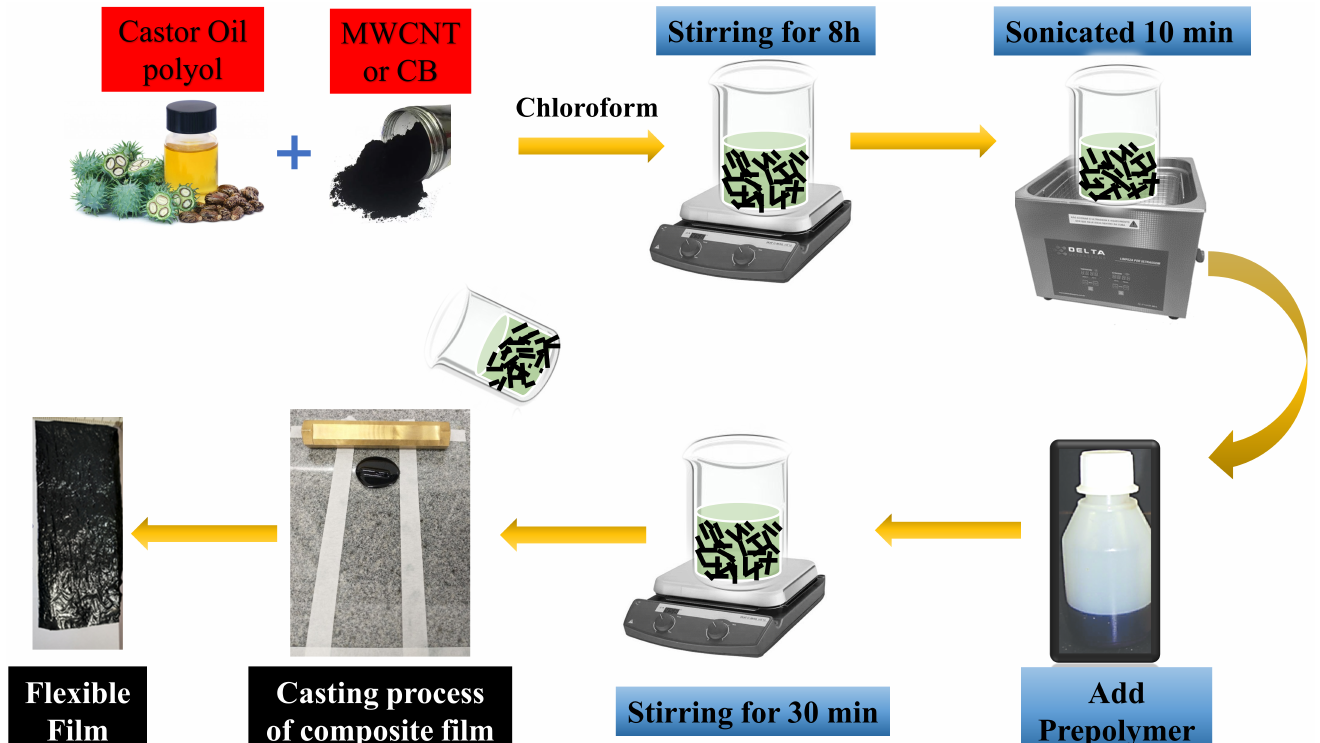
Figure 1. Schematic representation of the preparation of conducting nanocomposite